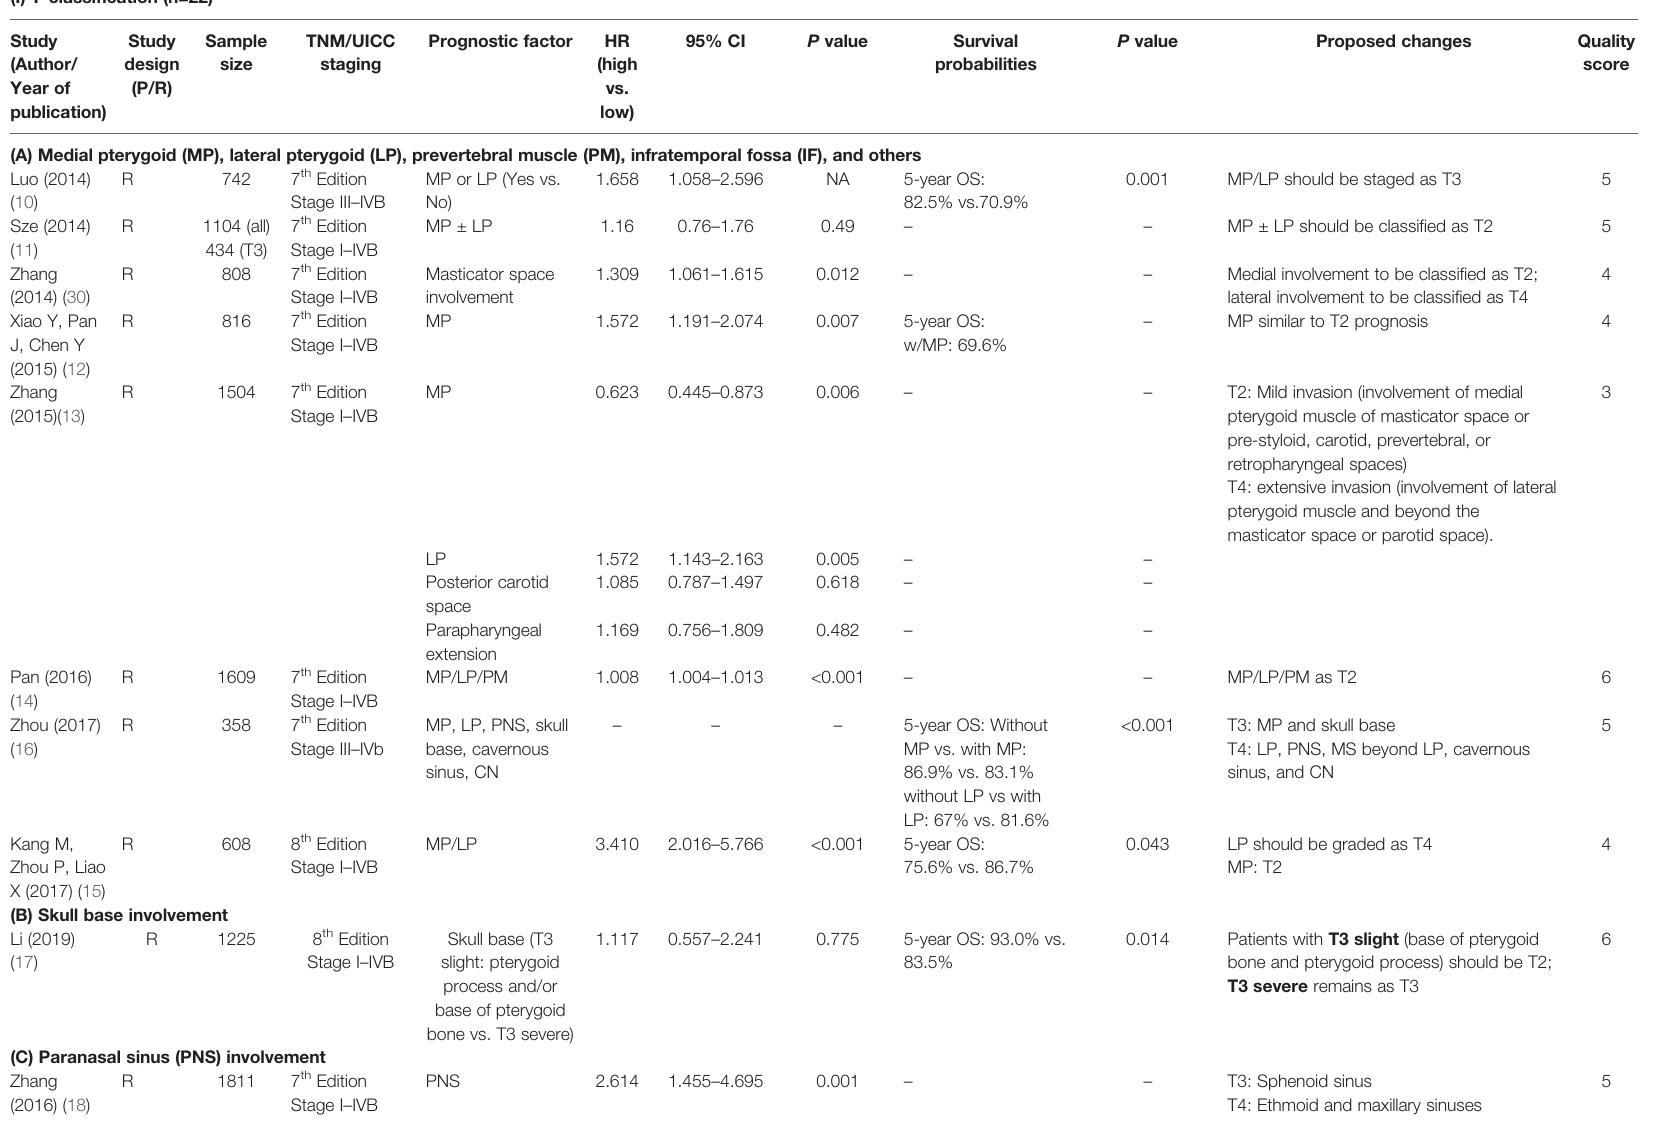
TABLE 2 | Characteristics of studies of T-, N-, and M-classi fi cation prognostic factors and survival